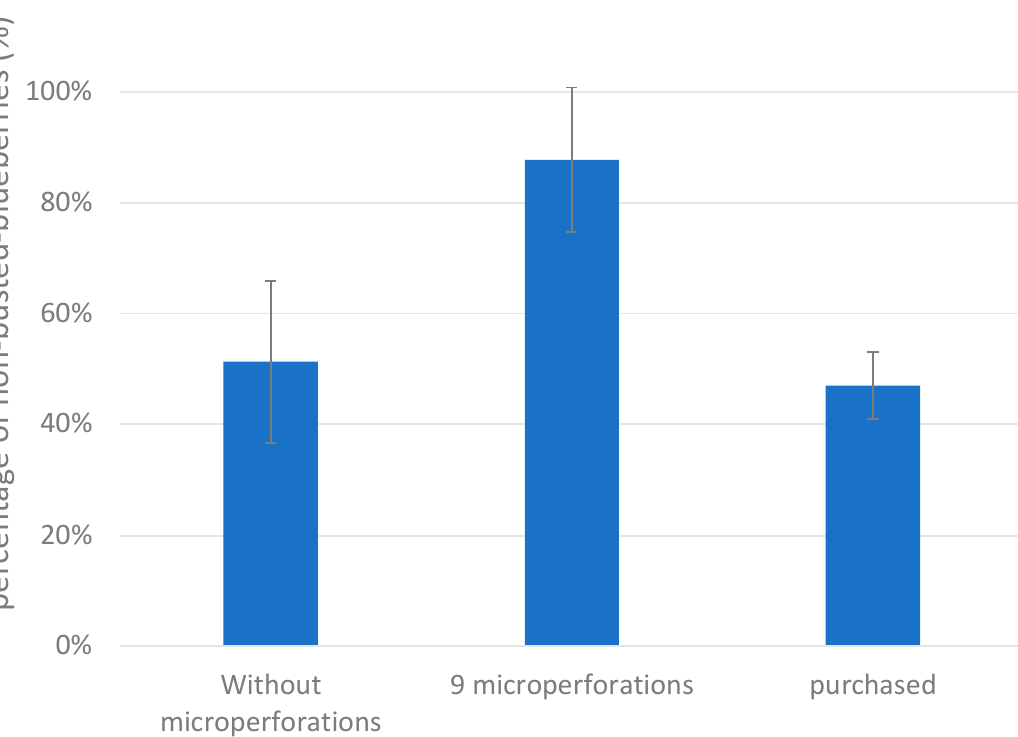
Figure 12. Di ff erences between freeze-dried blueberries as a ff ected by pretreatment and comparison Figure 12. Differences between freeze-dried blueberries as affected by pretreatment and comparison with those that can be found in local markets. Foods 2020 , 9 , x FOR PEER REVIEW with those that can be found in local markets.